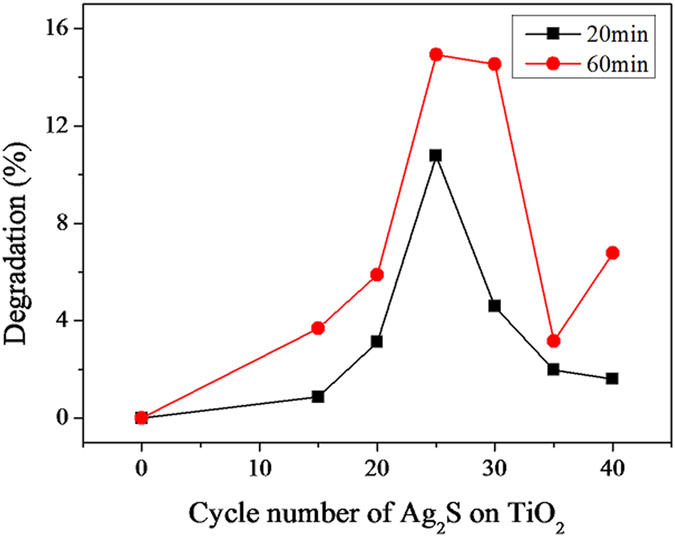
Photocatalytic degradation rates of MO under visible light irradiation using TiO2 NRAs (0 cycle) and Ag2S-coupled TiO2 for various cycles for 20 min and 60 min, respectively.